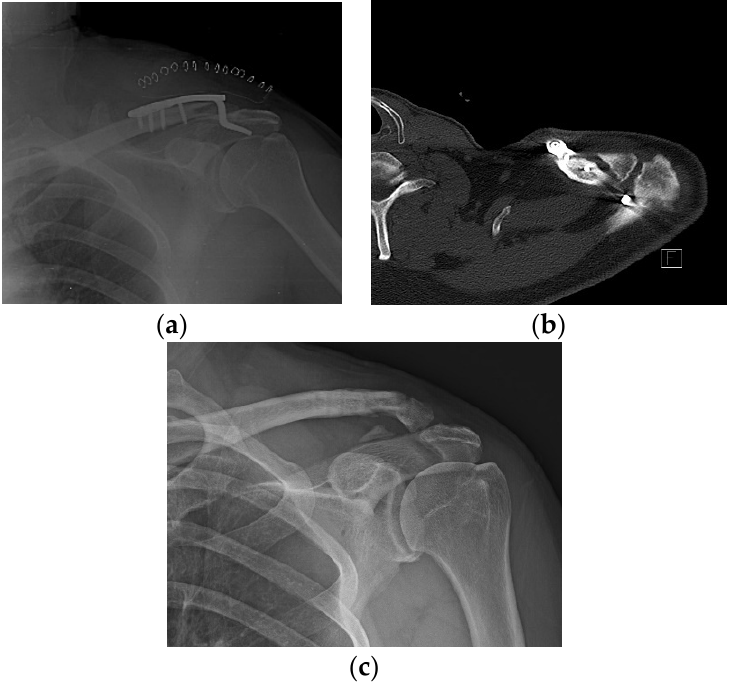
Figure 4. Incomplete union. ( a ) A 57-year-old male patient 4 months after hook plate fixation. ( b ) The plate is removed after incomplete union on patient request. ( c ) Bone union is achieved during follow-up.